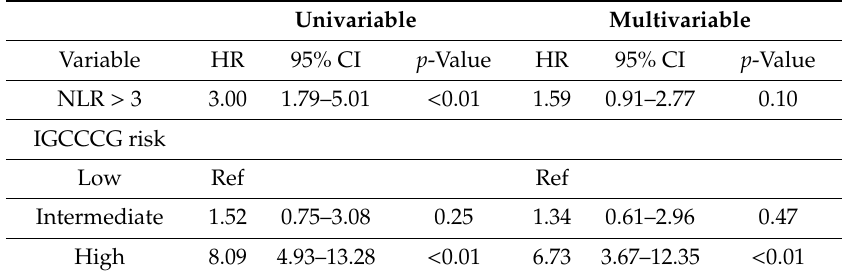
Figure 2. Discriminatory accuracy (AUROC) of the IGCCCG group and NLR, separate and combined for overall survival (OS). Table 2. Univariable and multivariable analyses for overall survival (OS) according to dNLR >